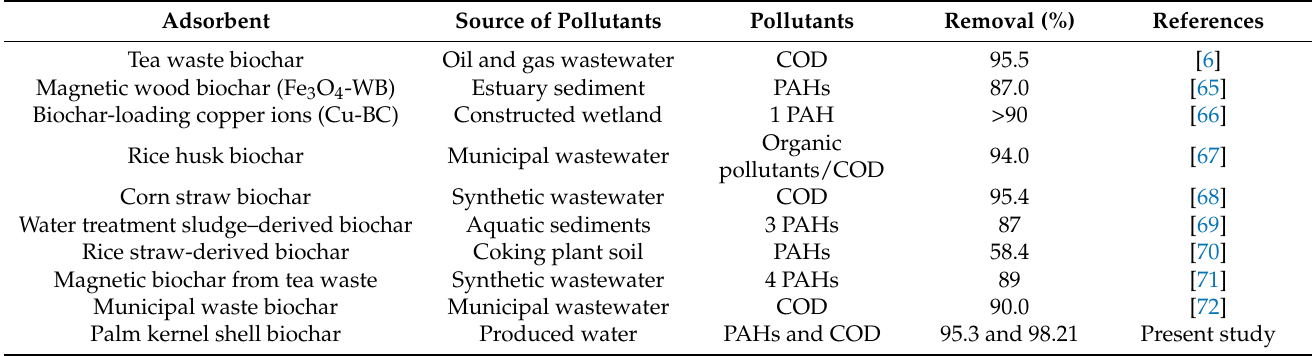
Table 6. Comparison among the current and previous studies that used biochar for PAH and COD removal.